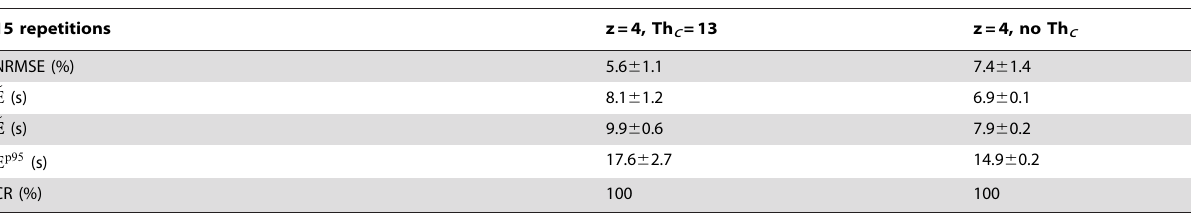
Table 3. Cross-Validation